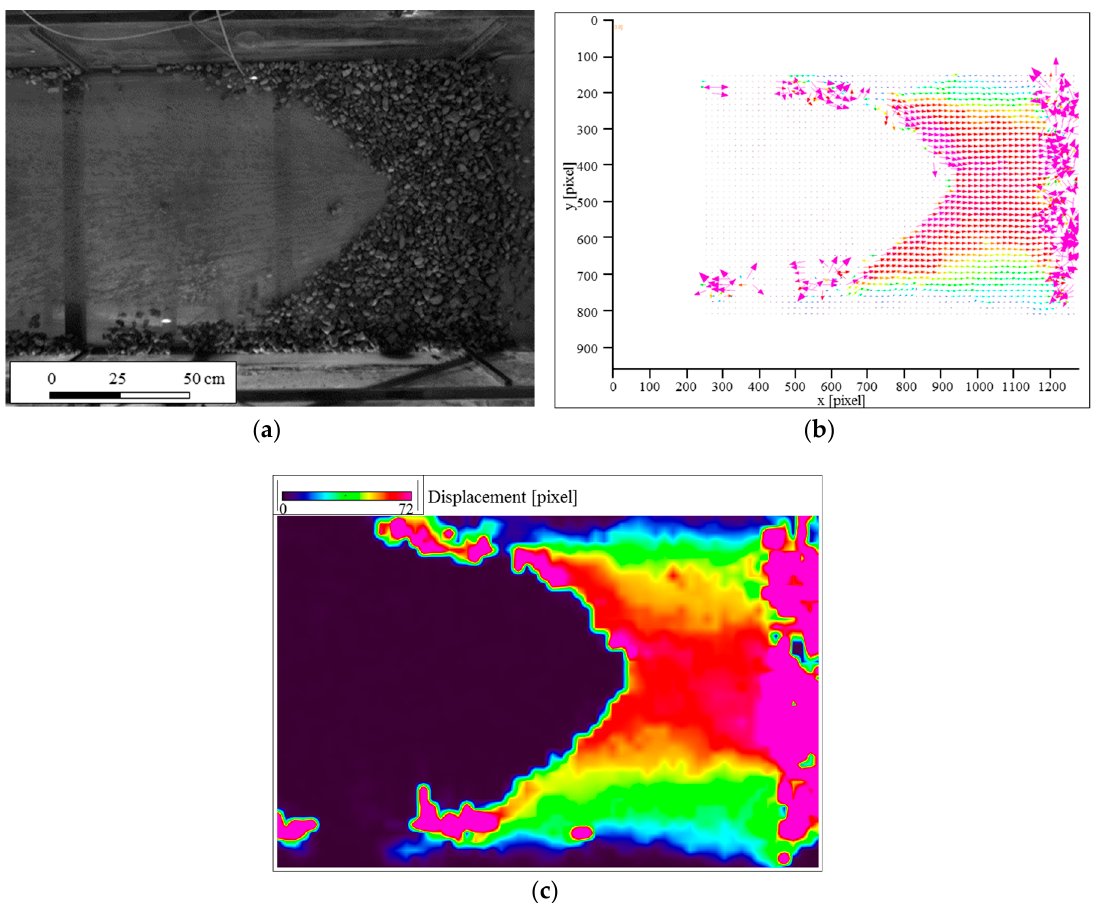
Figure 6. ( a ) Instant of a test; ( b ) field of velocity; and ( c ) field of displacements.